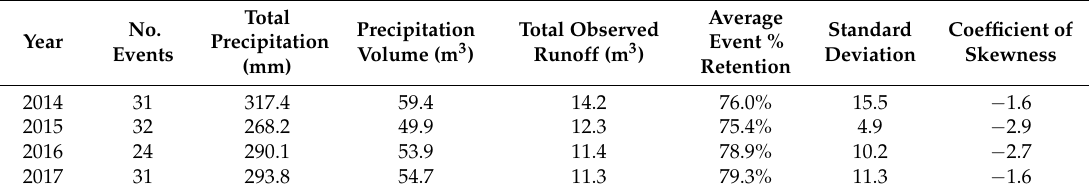
Table 4. Observed annual Javits Green Roof (JGR) performance.